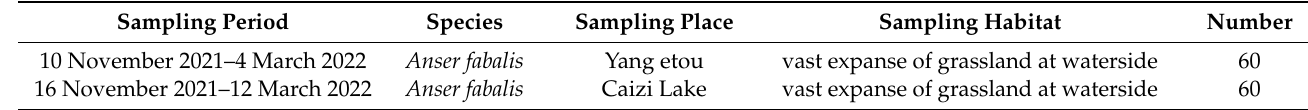
Table 1. Information form of Anser fabalis fecal sample collection.